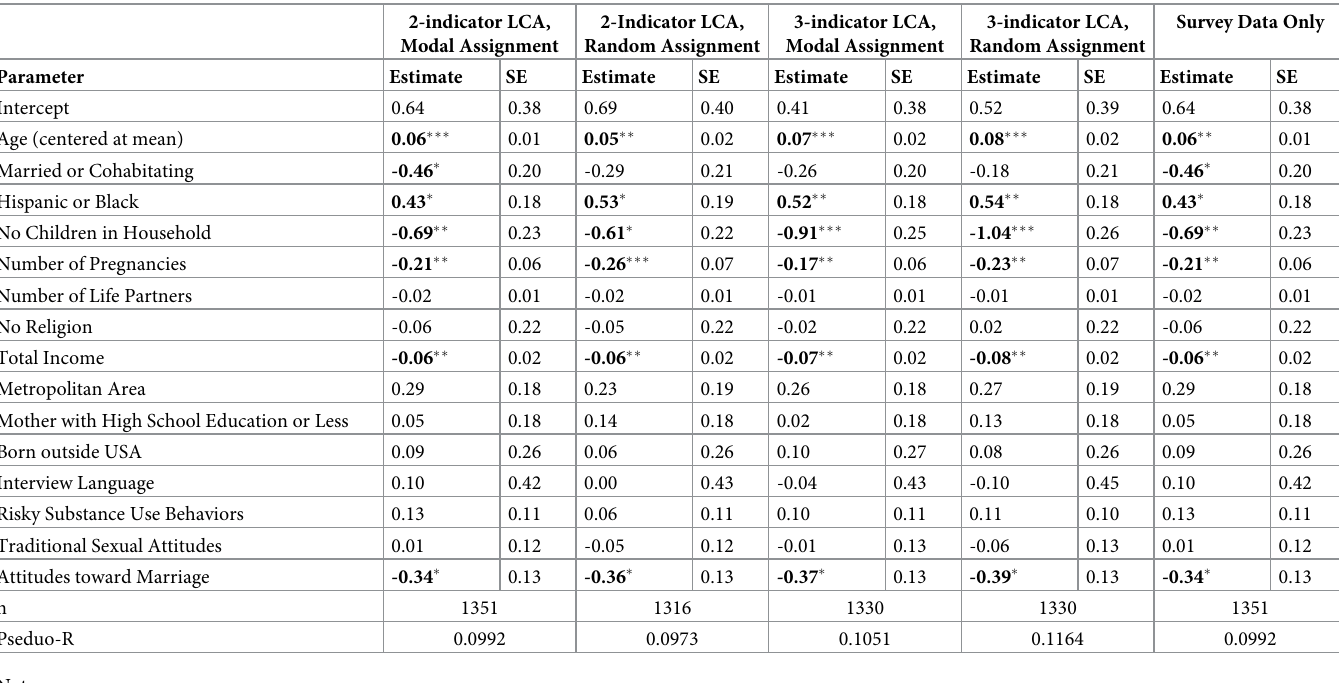
Table 6. Logistic regression coefficients in models predicting underreporting of